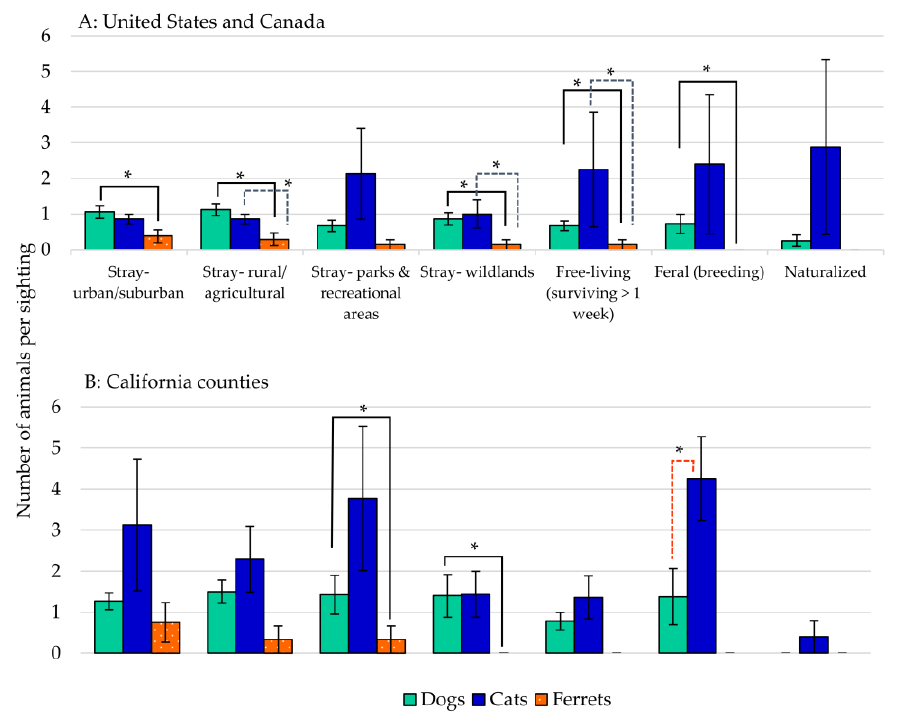
Figure 1. Frequency of sighting for unconfined dogs, cats, and ferrets for: ( a ) United States, and Canada ( b ) California counties. Rating mean ± standard error of the mean (sem). Asterisk represents significant difference; * p < 0.05, *** p < 0.001.